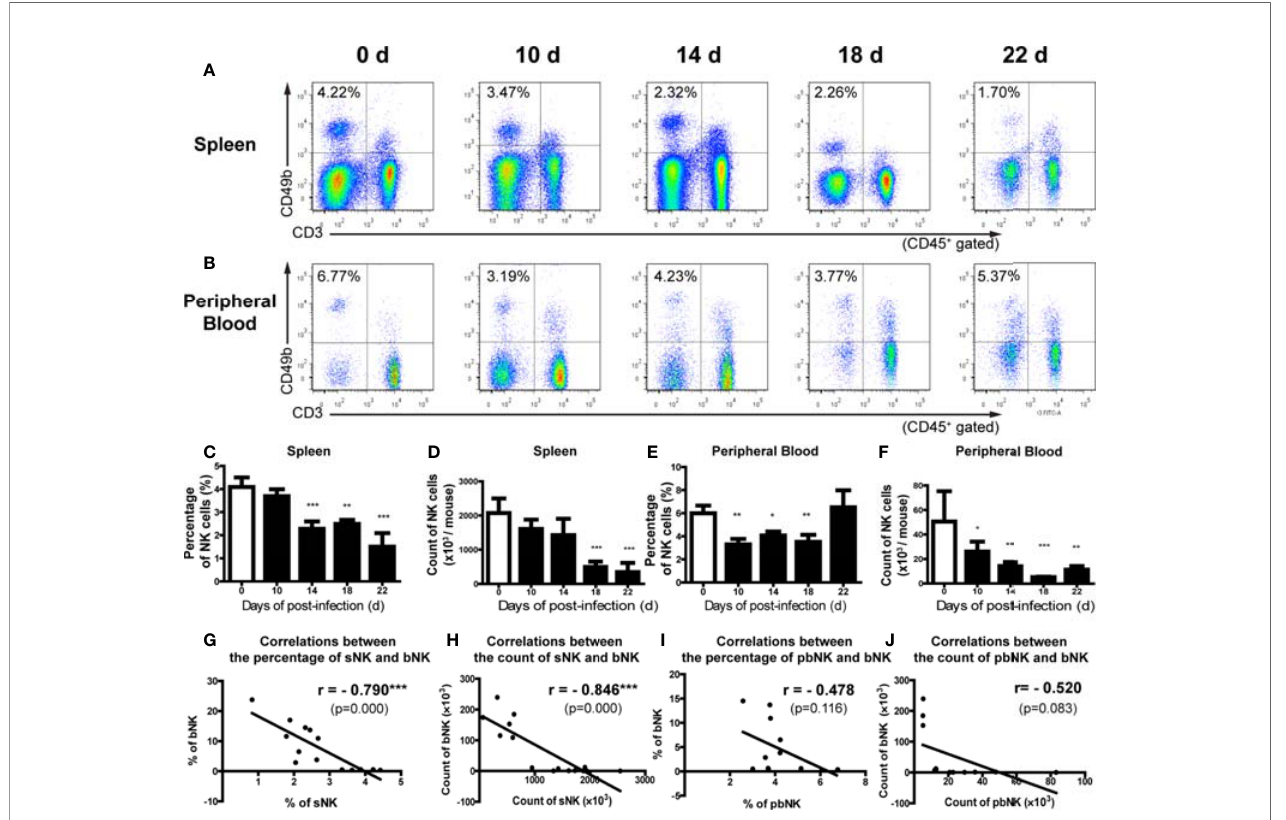
FIGURE 2 | The percentage and absolute number of NK cells in spleen and peripheral blood decreased after A. cantonensis infection. (A, C, D) The percentage and absolute number of NK cells in splenic lymphocytes of infected mice. (B, E, F) The percentage and absolute number of NK cells peripheral blood mononuclear cells of infected mice. NK cells in the splenic lymphocytes and peripheral blood mononuclear cells were detected by FCM. (G, H) The correlation between the percentage and absolute number of NK cells in spleen and brain. (I, J) The correlation between the percentage and absolute number of NK cells in peripheral blood and brain. Data are expressed as the means ± SD. Data shown represent analysis from two independent experiments with three mice per group. Multiple comparisons of the percentage and count of NK cells at different time-points of infection were performed by one-way ANOVA. The correlation between the percentage and absolute number of NK cells in different tissues was analyzed by linear correlation. * P < 0.05; ** P < 0.01; *** P < 0.001, compared with that of 0 dpi. sNK, NK cells in spleen; bNK, NK cells in brain; pbNK, NK cells in peripheral